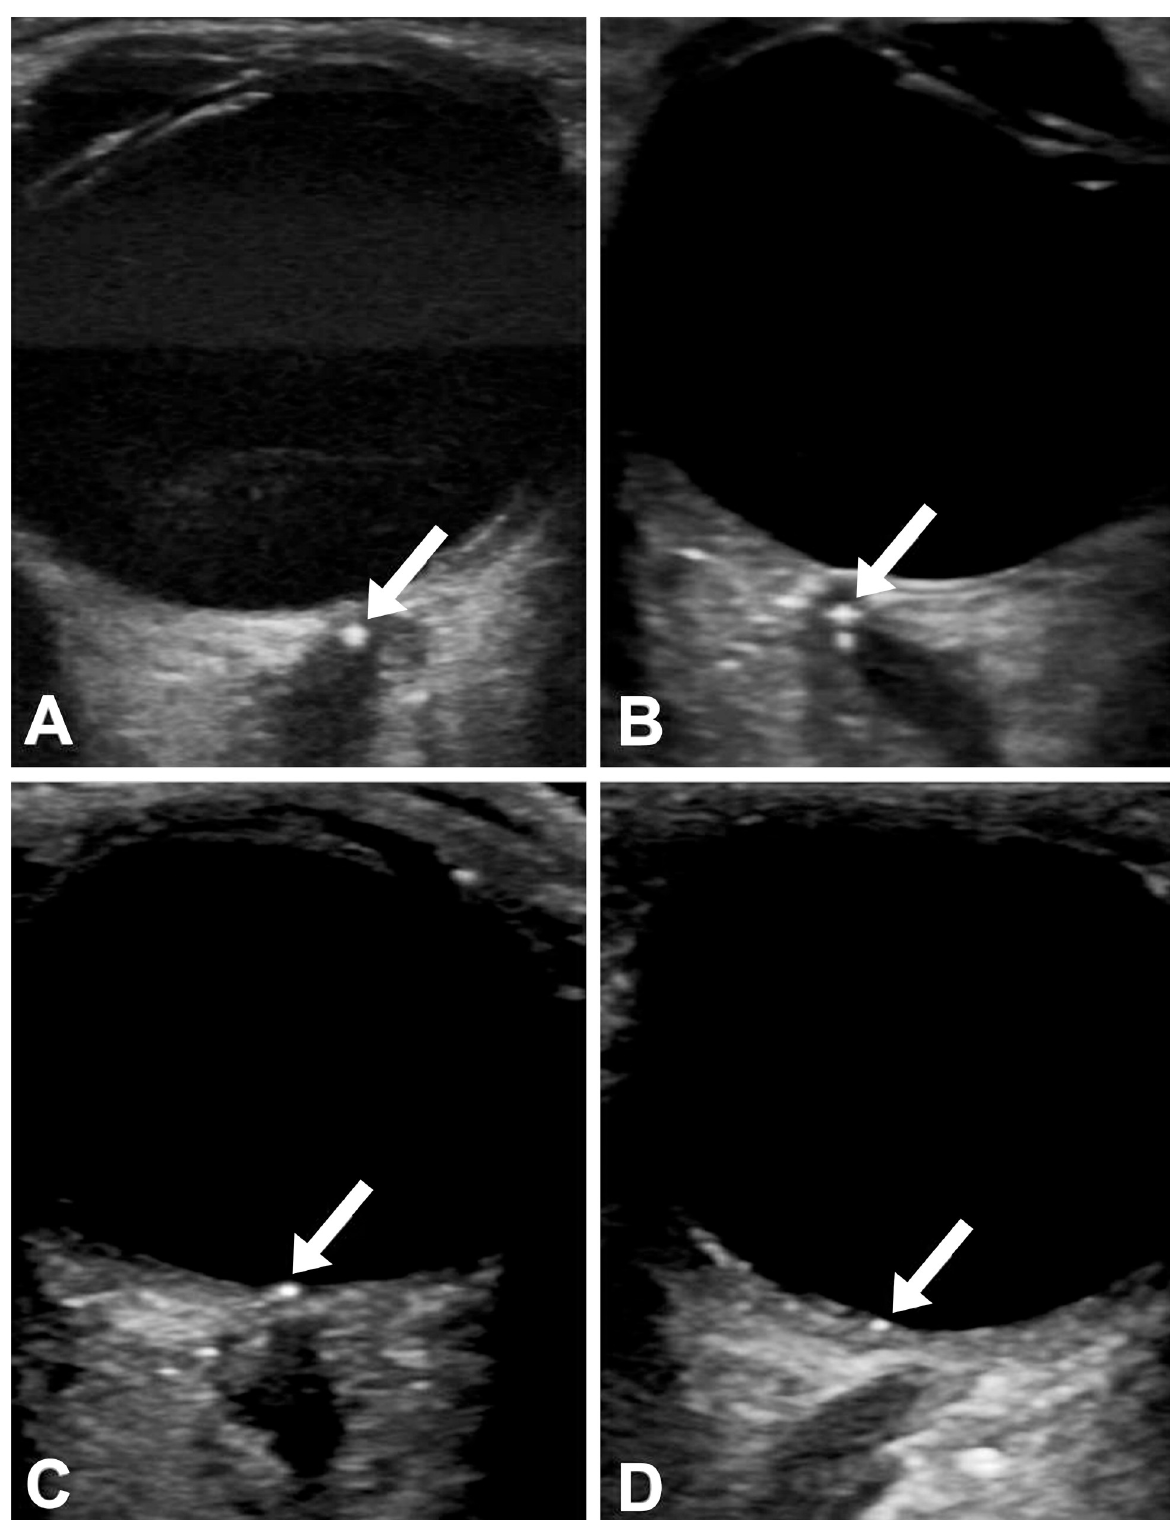
Fig 1. Spot sign on transocular B-mode ultrasound. Spot sign at the level of the optic nerve with (A) and without (B) comet tail artefact in CRAO. Spot sign at the level of the optic nerve disc (C) and the retina nearby the optic nerve disc (D) in BRAO is shown.